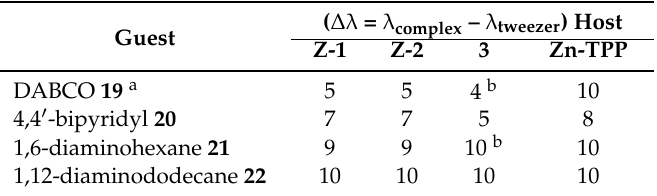
Table 3. UV-vis red shift of Soret bands upon binding ( ∆ λ = λ complex ´ λ tweezer ) for molecular tweezers Z - 1 , Z - 2 and 3 (CH 2 Cl 2 solution, r.t.).